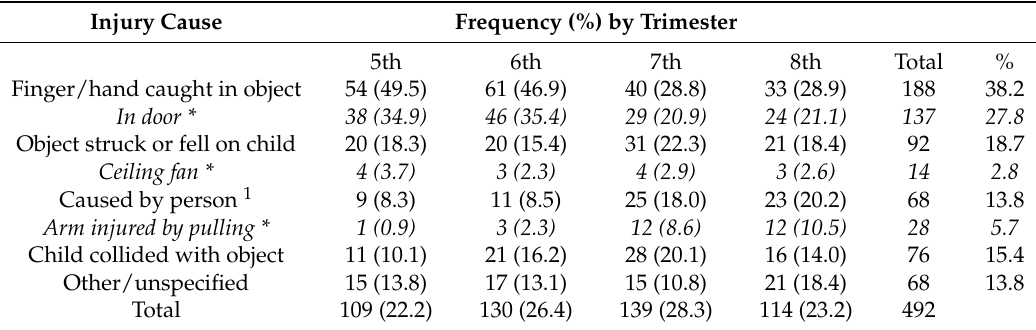
Table 6. Causes of injury under the Contact